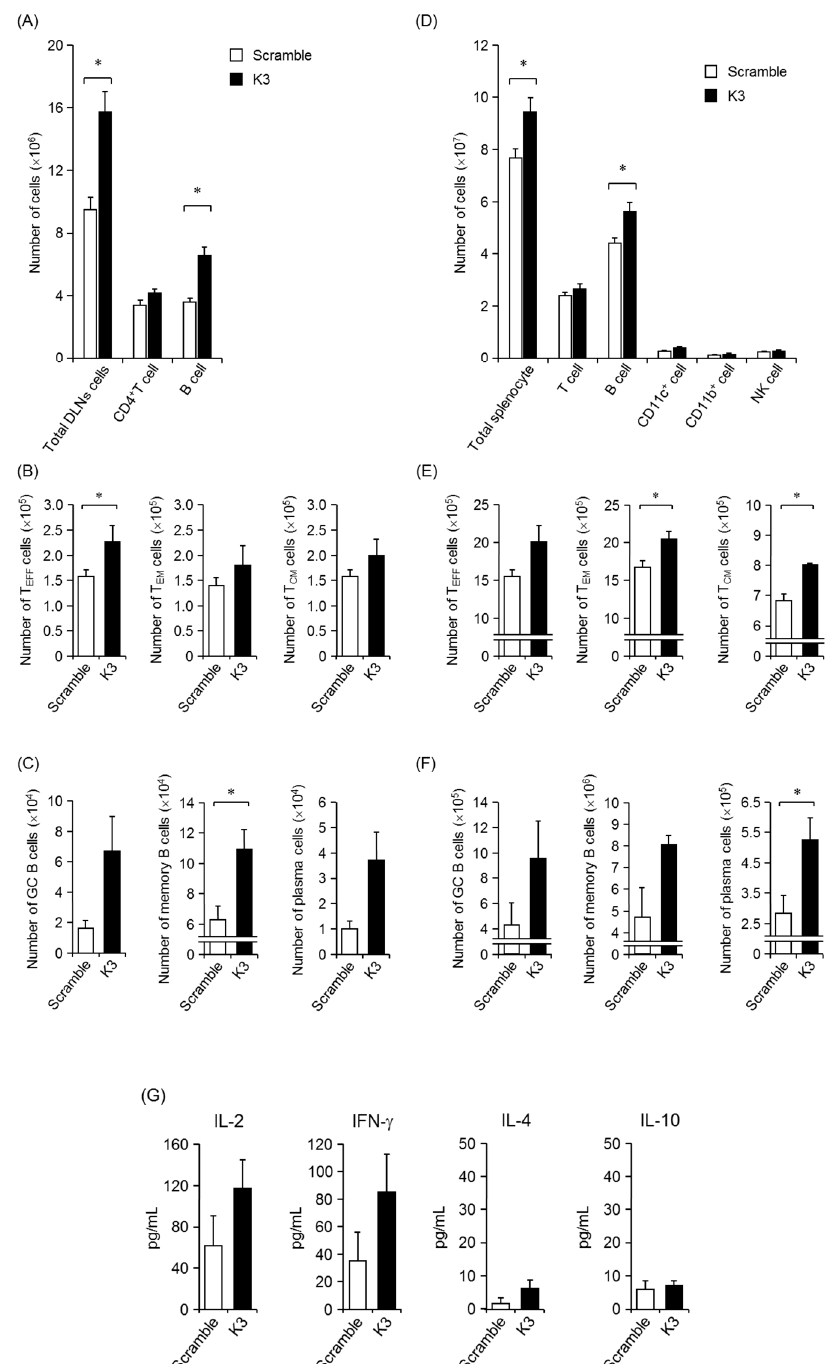
Figure 4. Activation and differentiation of T- and B-cells in combination with K3. C57BL/6 mice were epicutaneously immunized three times at 2-week intervals with K3 or the scramble control using the poke-and-patch method. The DLNs and spleens were collected 2 weeks after the final immunization; the number and differentiation of each immune cell was analyzed by flow cytometry ( A , D ). Activated T cells in the DLNs and spleens were analyzed using CD44 expression, and then fractionated into T EFF , T EM , or T CM populations by surface marker expression ( B , E ). The DLNs and spleens were stained for GC B cells, memory B cells and plasma cells ( C , F ). The splenocytes were prepared and cultured with 1 mg OVA for 48 h ( G ). The supernatant from these cultures was collected and cytokine production was evaluated with a Bio-Plex. Data are expressed as mean ± SEM of results from three mice. Data are expressed as mean ± SEM of results from three to five mice. (Student’s t -Test, * p < 0.05).